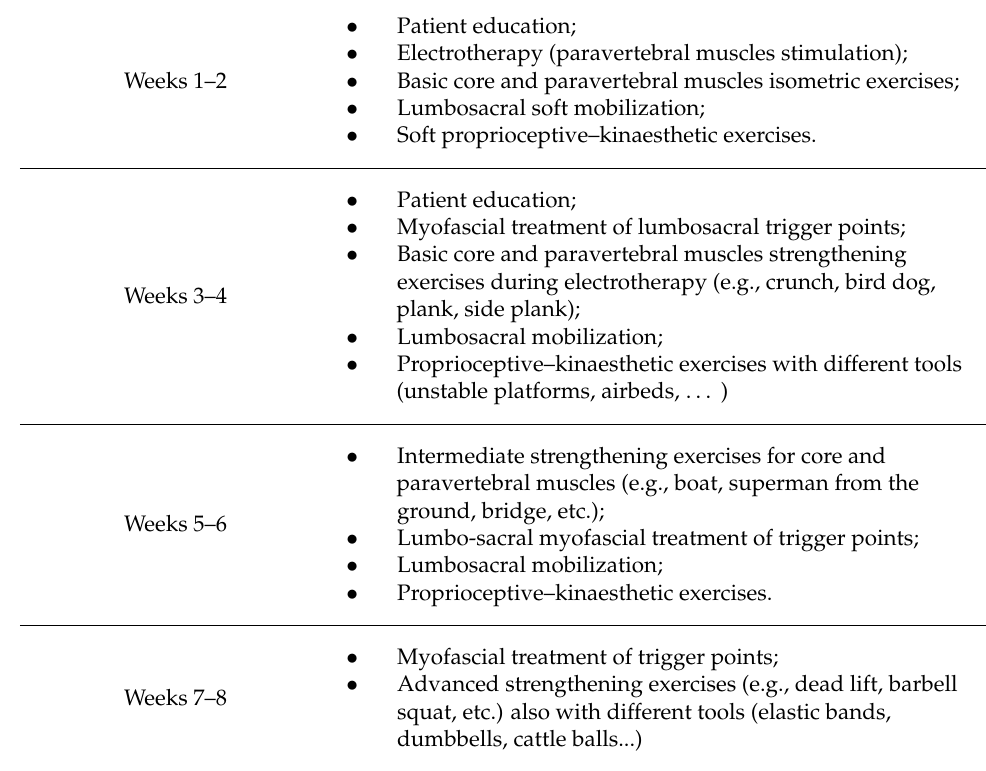
Table 2. Rehabilitation